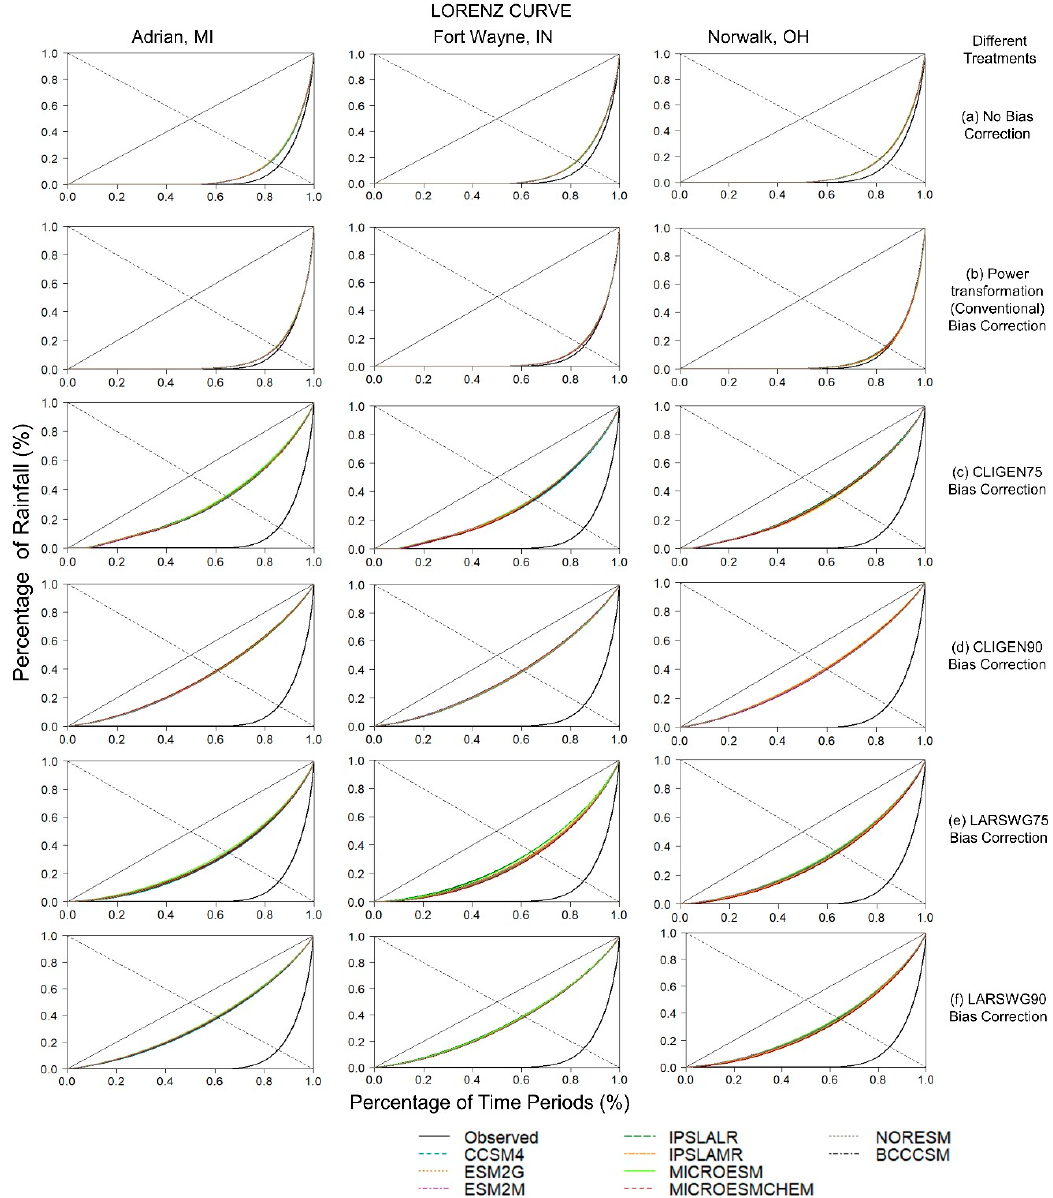
Figure 8. Performance evaluation of different bias correction methods for a historic period (1966–2005) in reducing the bias in the daily time series in simulating daily precipitation, mm for Adrian, MI; Fort Wayne, IN; and Norwalk, OH using Lorenz Curve.